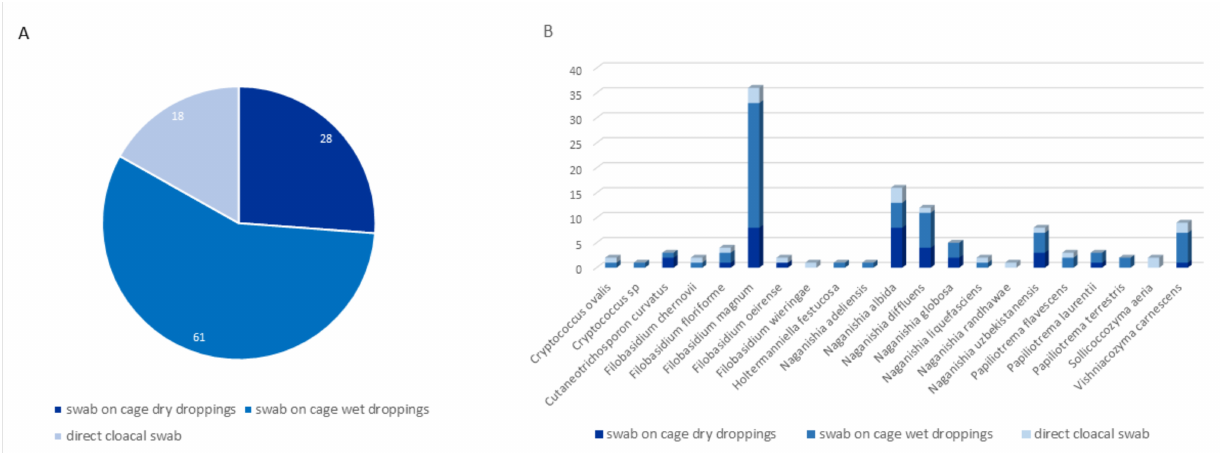
Figure 2. Distribution of samples positive for rare Cryptococcus and former Cryptococcus spp. ( A ): Overall distribution of positive samples by type of sampling. ( B ): Distribution of Cryptococcus and former Cryptococcus species by type of